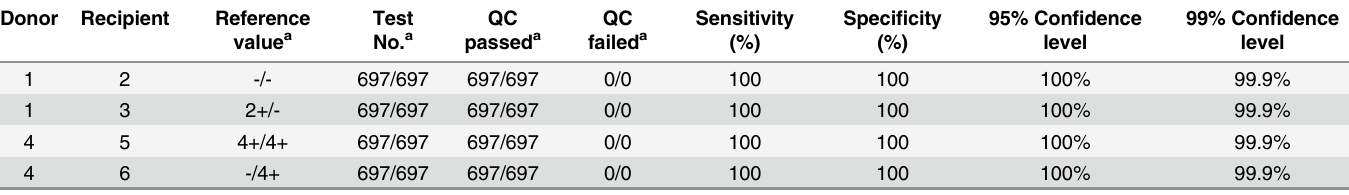
Table 3. Analysis of IQC for